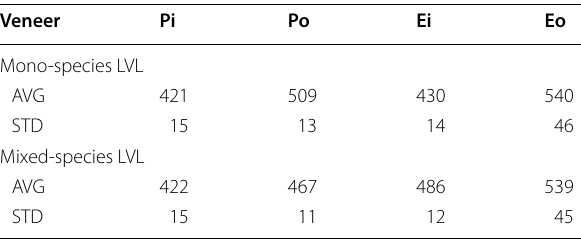
Table 2 Density of veneer used to make LVL